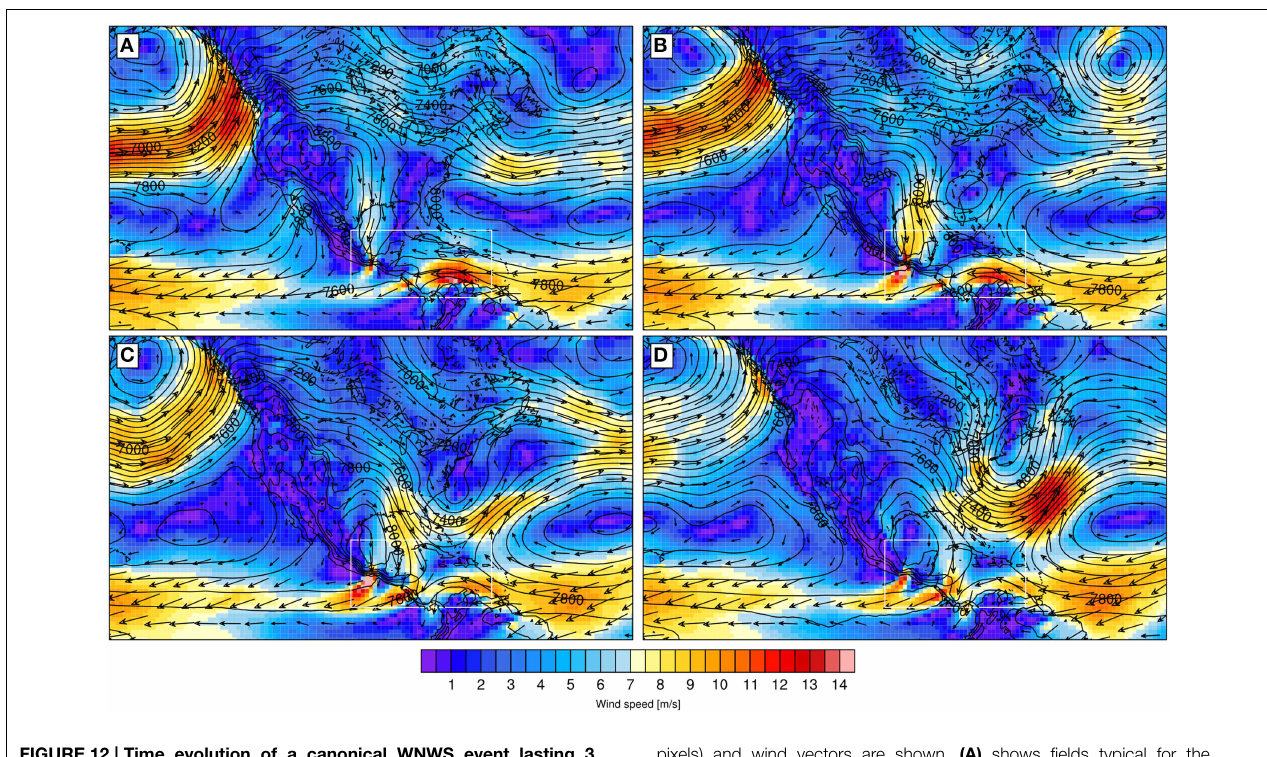
FIGURE 12 | Time evolution of a canonical WNWS event lasting 3 days. Composites for the large-scale patterns at 925 hPa for geopotential height [m/s] (black contours), wind speed [m/s] (colored